Question: Give a one-sentence summary of this figure.
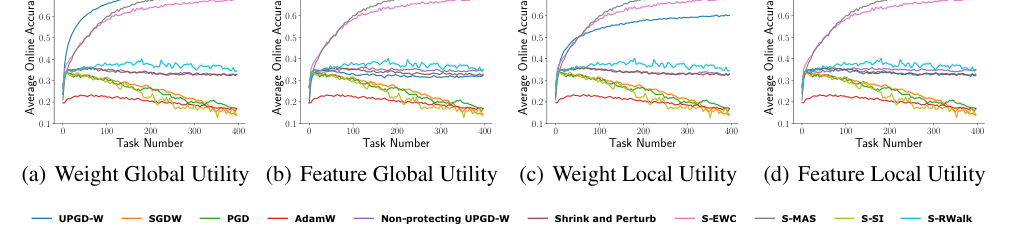
Answer: Performance of methods on Label-permuted EMNIST. First-order utility traces are used for UPGD and Non-protecting UPGD. Results are averaged over 10 runs.